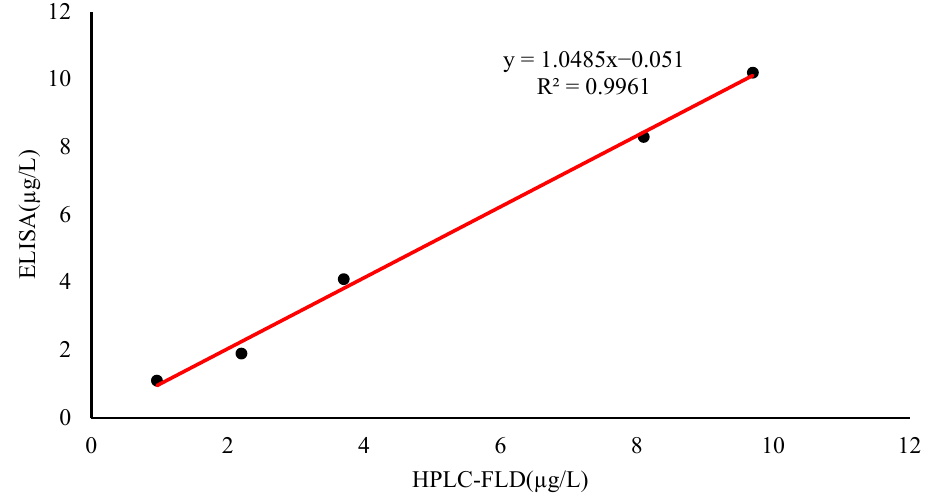
Figure 5. Correlation between ic-ELISA and HPLC-FLD for PYR determination of positive fish sample.